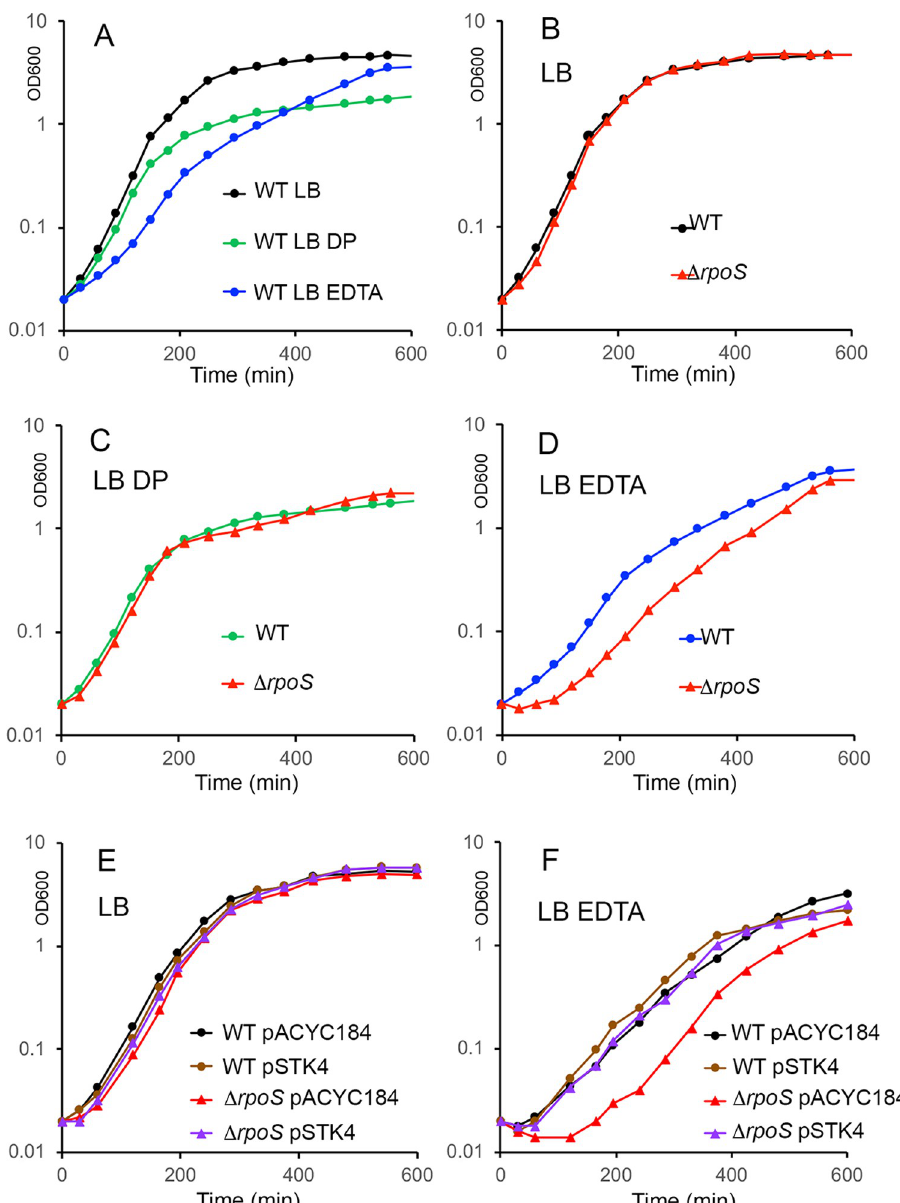
Fig 7. The metal ion chelator EDTA extends the lag phase of the Δ rpoS mutant. (A, B, C, D) Kinetics of growth of the wild-type strain (WT, VF6910) and the Δ rpoS mutant (VF8158) was followed in LB supplemented or not with EDTA 2 mM or DP 200 μ M. (E, F) The empty vector pACYC184 and plasmid pSTK4 carrying the rpoS gene were used in complementation experiments. The growth phase was determined by the measurement of culture turbidity at OD 600 nm. Similar results were obtained with the two biological replicates of each strain that were tested (see S3A and S3B Fig for the second series of biological replicates). Similar results were also observed using an independent Δ rpoS construct (VFC331, S4